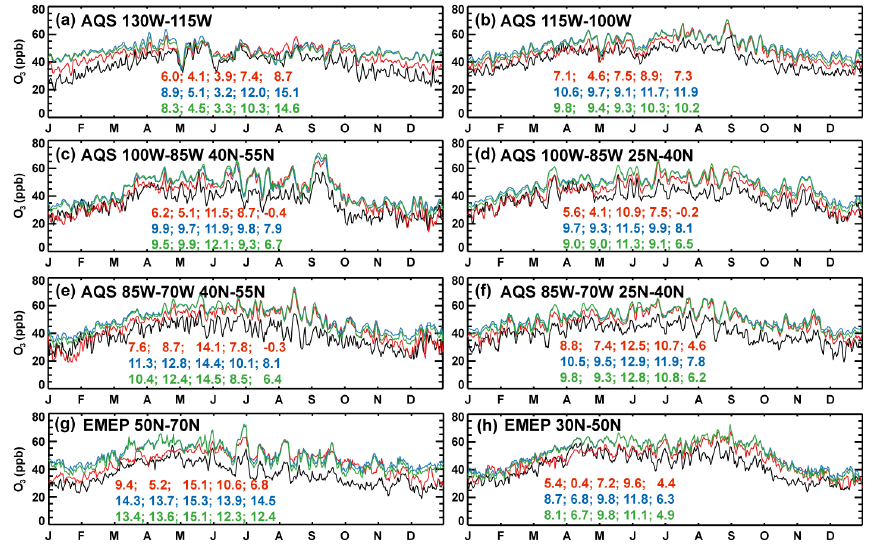
Figure 4. Day-to-day time series of afternoon (12:00–18:00LT) mean ground-level ozone from AQS and EMEP measurements (black lines) and from model simulations (red lines for two-way coupled system, blue lines for global model alone and green lines for one-way nested models). Data are averaged over individual triangular regions indicated in Fig. 3. Numbers shown in each panel are mean model biases for